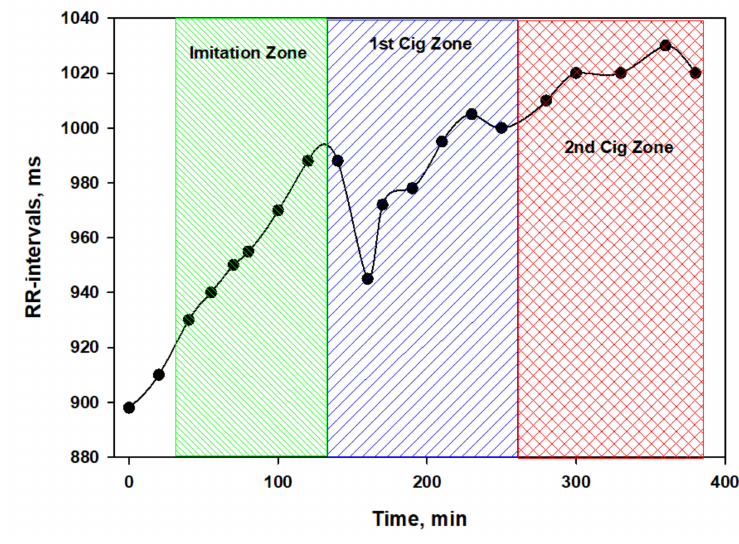
Figure 3. Dynamics of the RR intervals of a volunteer at different stages of testing a nicotine-free cigarette. To accurately determine the correspondence of the time coordinates of each stage of the experiment in the figure, the test protocol should be used. Green color—imitation of smoking, blue color—1st cigarette zone, red color—2nd cigarette zone. (Table S1, Supplementary Materials).